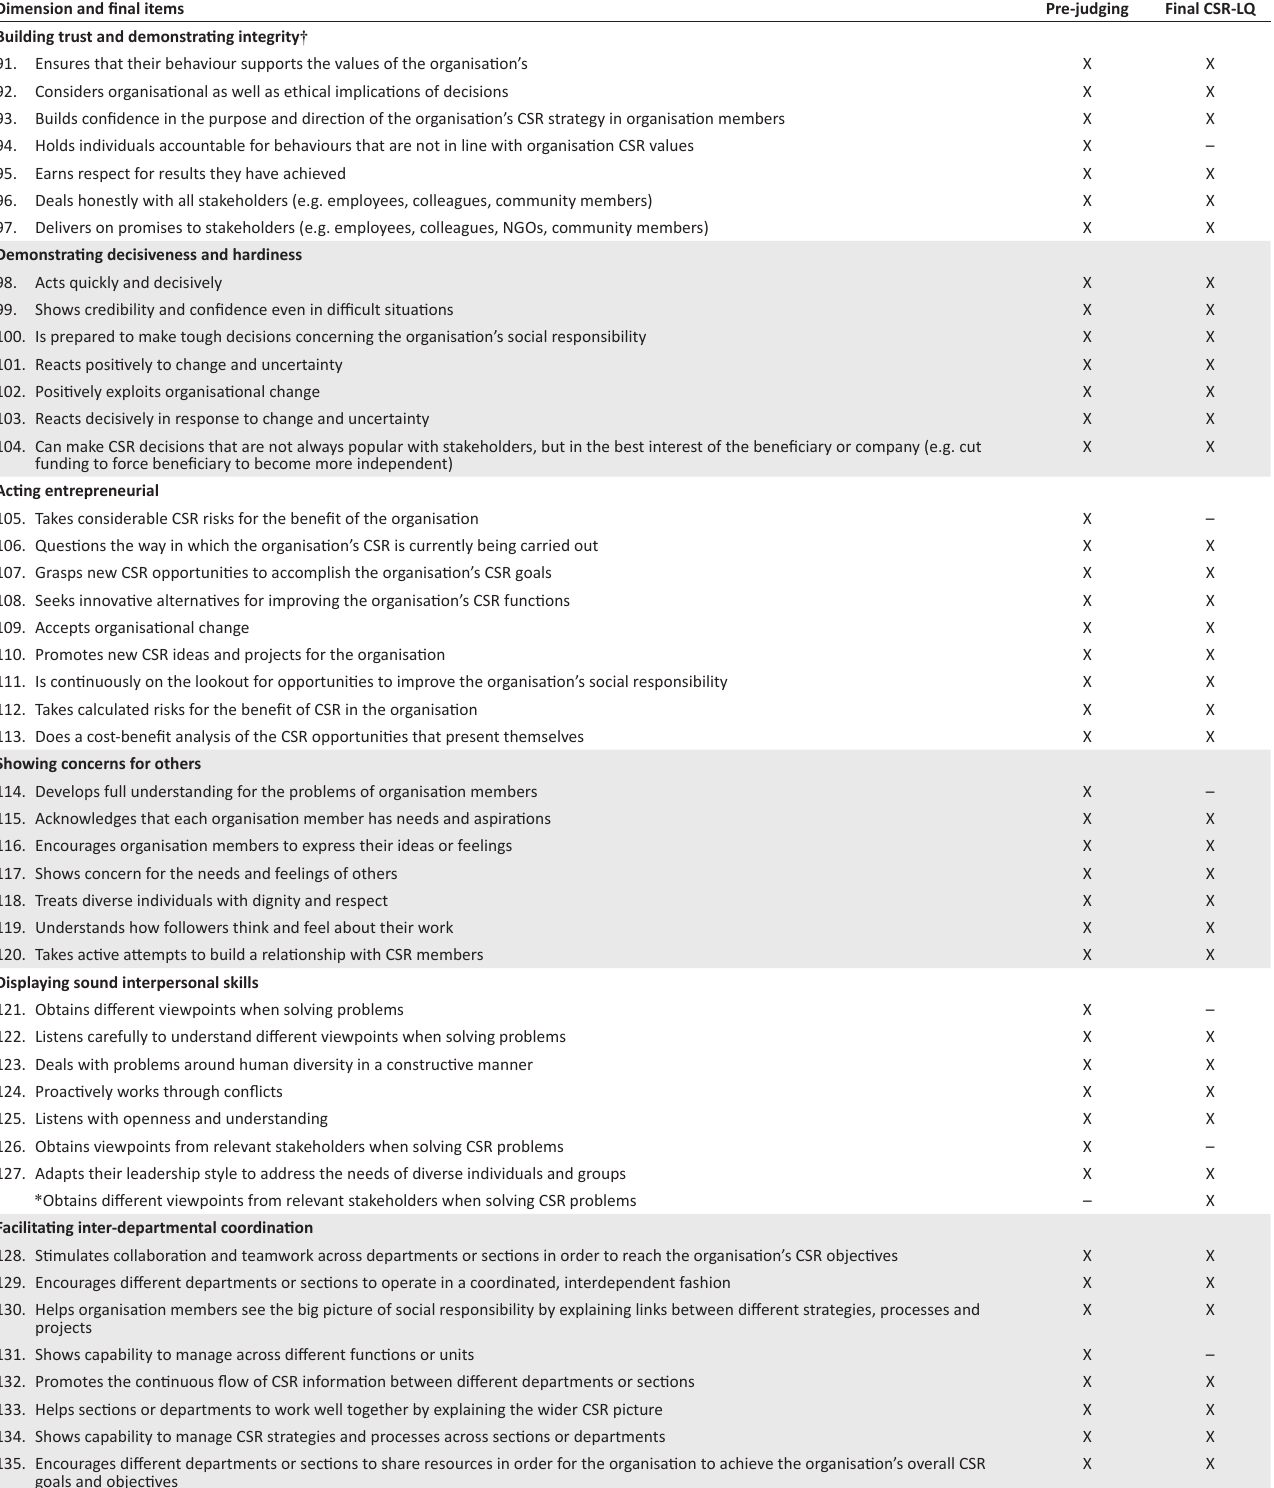
TABLE 4 (Continues): CSR-LQ items prior to and after expert